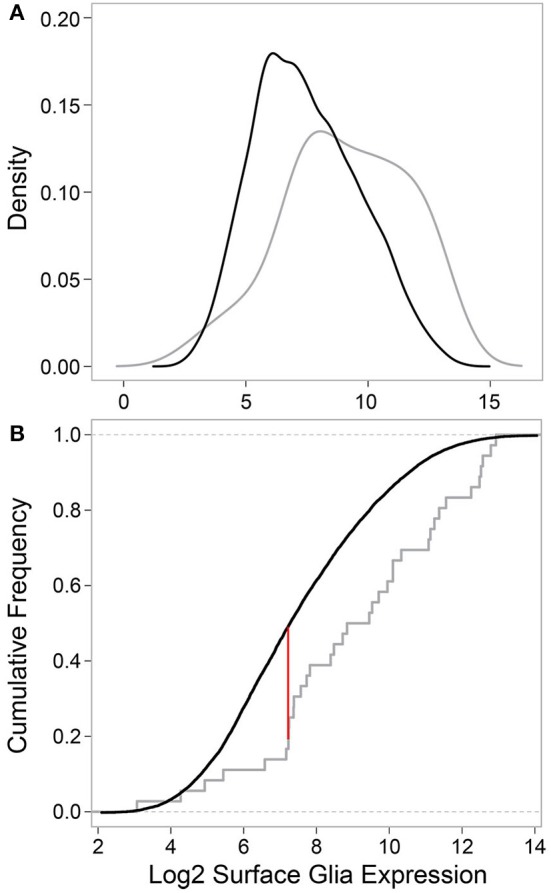
Comparing data for known surface glia genes to all other probes on the microarray validates the surface glia transcriptome. (A) Kernal density estimates based on surface glia log2 gene expression for known surface glia genes (gray) and all other probes on the microarray (black). The distribution of data for known surface glia genes is significantly greater than that for all other probes on the microarray (Two-sample Kolmogorov-Smirnov test, D = 0.3435, P = 0.0004). (B) A cumulative frequency plot of the same data also illustrates the significant difference in distributions between known surface glia genes and all other probes on the microarray. The red line corresponds to the D-statistic, the point of greatest separation between the curves. At this point, 81.6% of known surface glia genes have higher expression levels, which is in stark contrast to 51.7% for all other probes on the microarray.